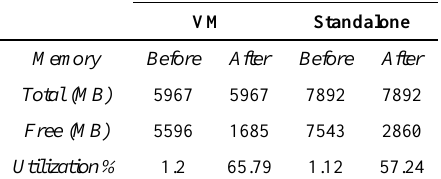
Table 4. Memory utilization in scenario